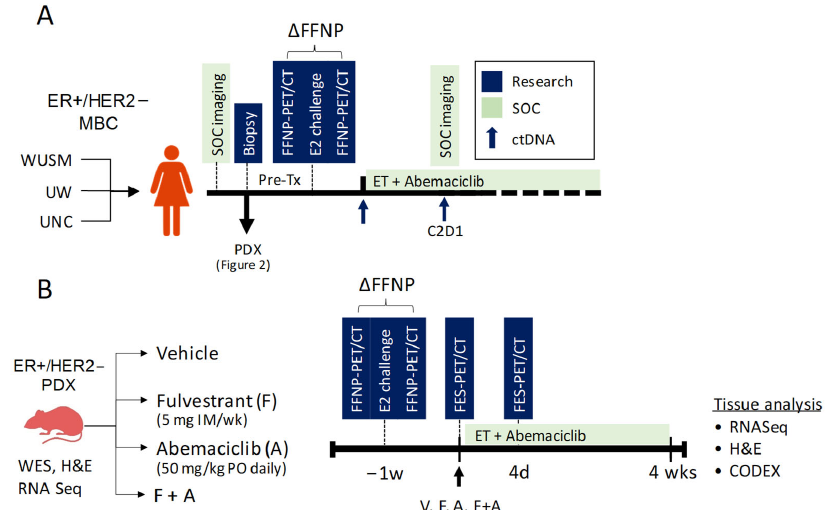
Figure 9. Co-clinical study design. ( A ) Multicenter clinical imaging trial to predict response to Figure 9. A TBCRC multicenter clinical trial to predict response to ET using Δ FFNP-PET supported by the BCRF. Please refer to text for details. PDX are generated from biopsies described in Figure 8. ET using ∆ FFNP-PET in patients with advanced ER+/HER- BCa. Tissue biopsies will be used for genopro-teomic discovery and to generate PDX. ( B ) The preclinical PDX imaging protocol to assess Overall, these projects aim to have high, far-reaching impact on the implementation the efficacy ∆ FFNP-PET and FES-PET in predicting response to Fulvestrant and Abemaciclib, alone of co-clinical imaging strategies in identifying, stratifying, and predicting response to and in combination, followed by pathology and genoproteomic therapy in TNBC and ER+/HER2 − BCa, integrating QI with genoproteomic discovery. In addition, high-value, multi-scale analytic data will be generated to interrogate and